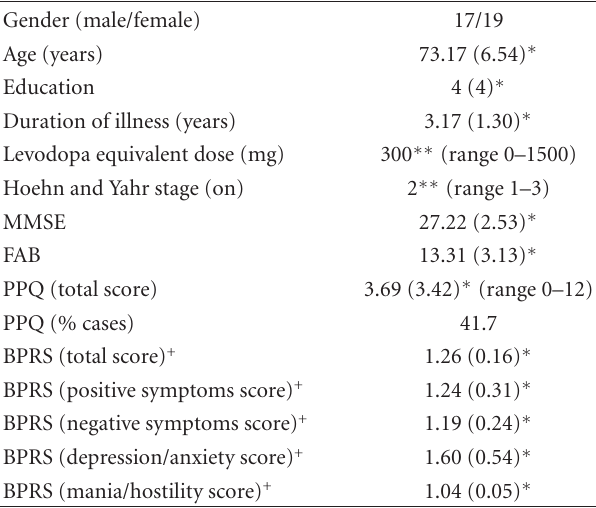
Table 1: Sociodemographic and clinical data ( n =